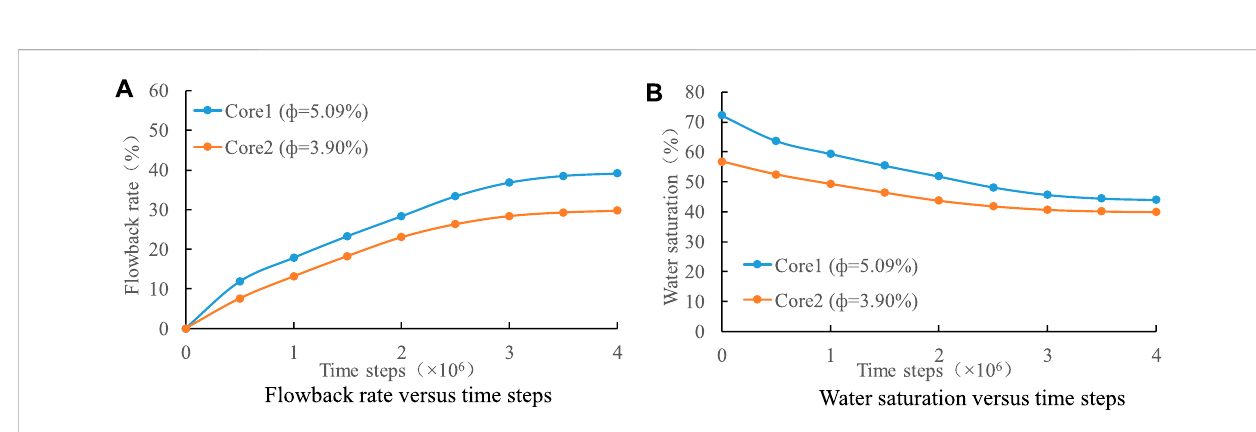
FIGURE 21 The fl owback rate versus time steps (A) and the water saturation versus time steps (B) in the fl owback process under different pore structures.